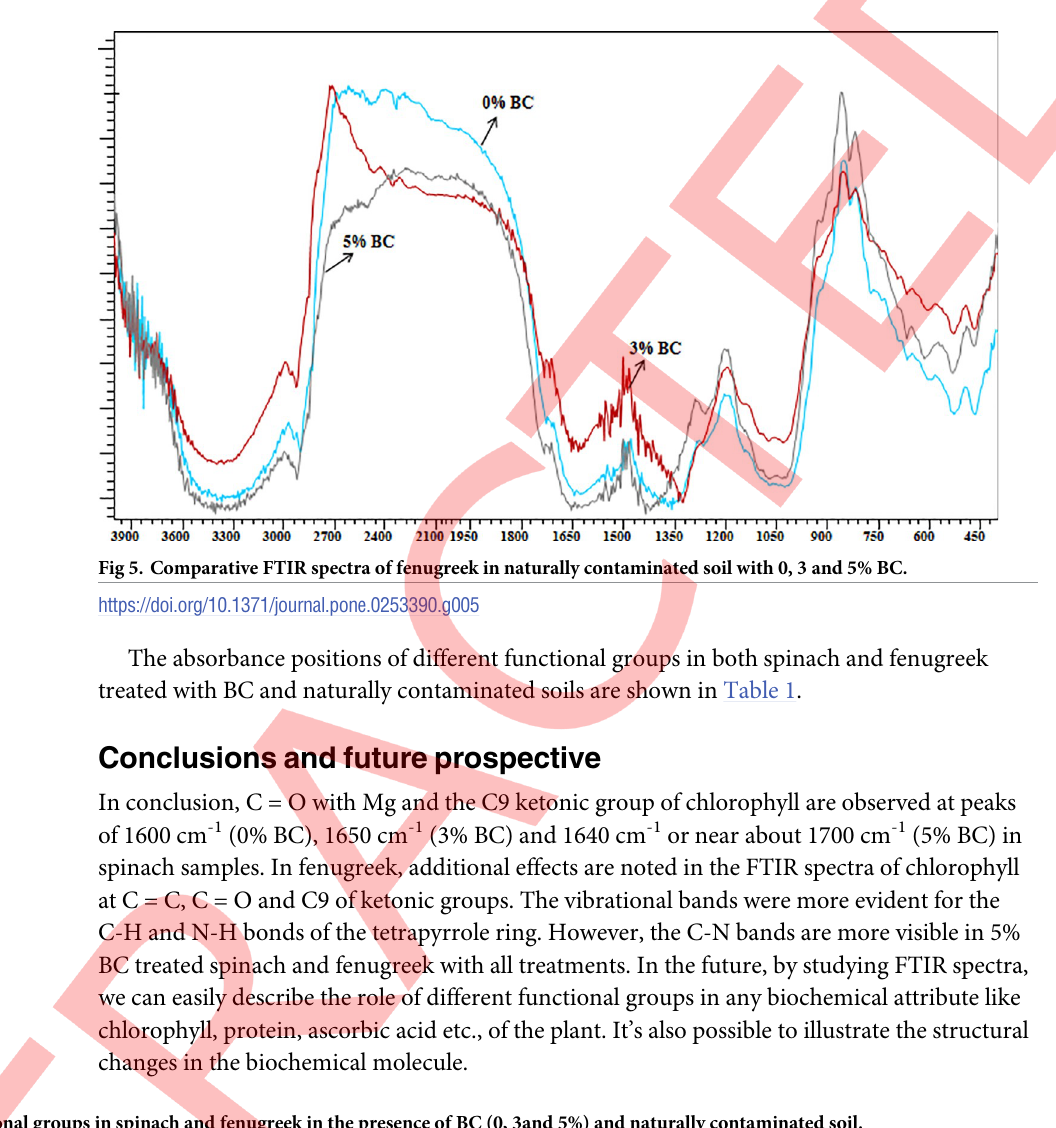
Table 1. Vibrational modes of functional groups in spinach and fenugreek in the presence of BC (0, 3and 5%) and naturally contaminated soil. Functional Groups